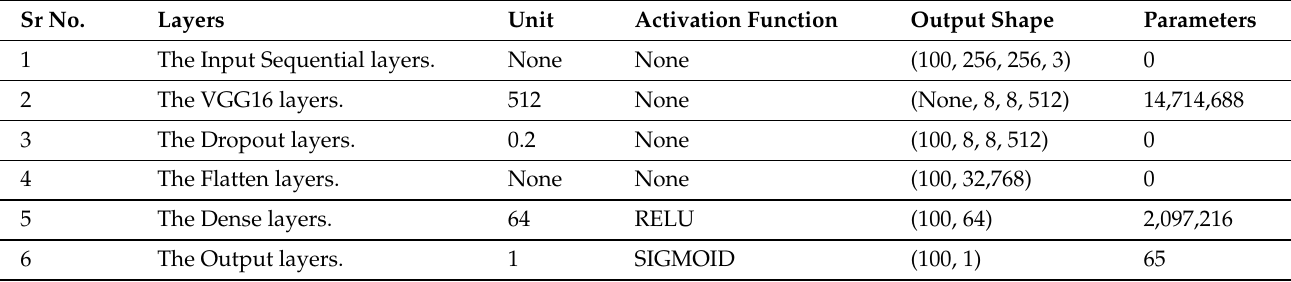
Table 5. The VGG16 model configuration parameters and layer architectural